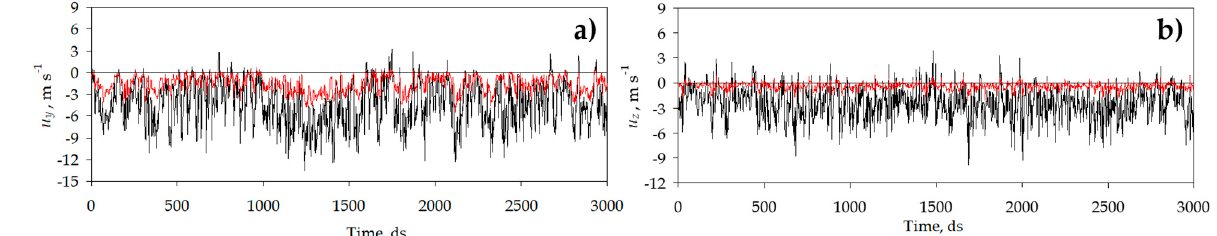
Figure 6. Three-dimensional sonic anemometry measurements from Test 1 at the side window windward oriented. The measurements correspond to the transversal component u y ( a ), and vertical component u z ( b ). Inner side of the IPS at the window ( ▬ ); outer side of the IPS at the window ( ▬ ). Total acquisition time: Five minutes.